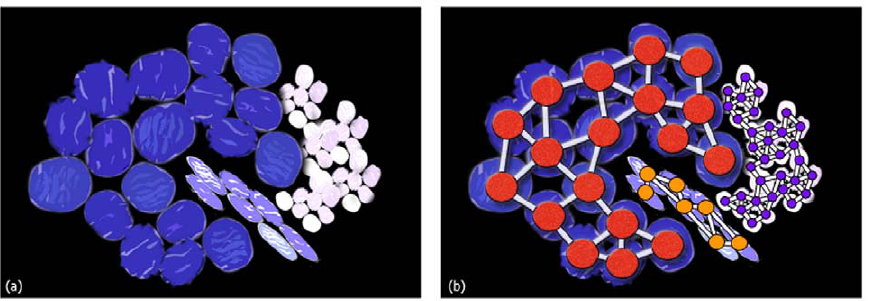
Figure 4. Conceptional representation of cell graphs. ( a ) Artificial sketch of 3 different 3 cell type: tumor cells in blue, lymphocytes in white and in purple fibroblast. ( b ) Cell graph representation of (a). Cells are depicted as nodes and links between them represent biological relations.